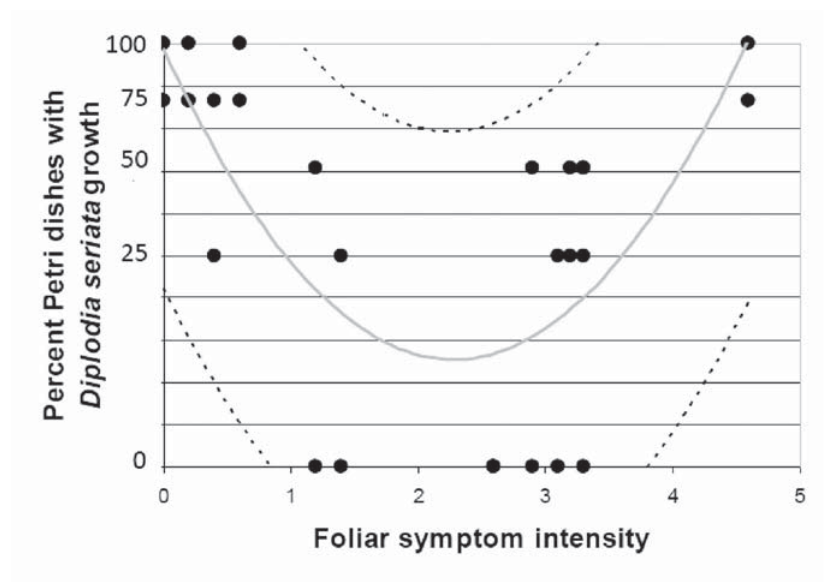
Fig. 3. Percent Petri dishes showing D. seriata growth vs. foliar symptom intensity. Each dot represents at least one arm, and dots in the same vertical line represent the different arms from the same plant. The continuous line is the polynomial fi tted to square root data (proportion of Petri dishes) =0.9877–0.6444 Symptom +0.1411 Symptom 2 . The dotted lines represent the 95% upper and lower con fi dence